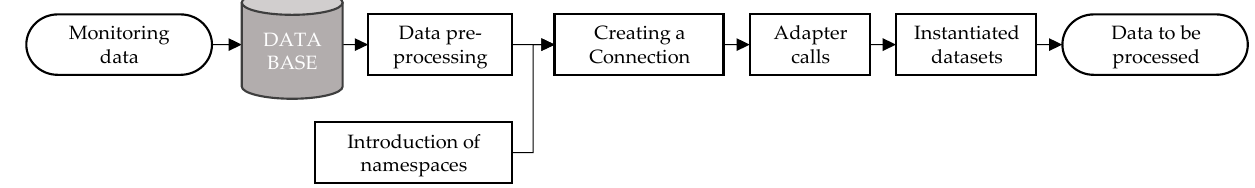
Figure 7. Flowchart of building a database and connection.